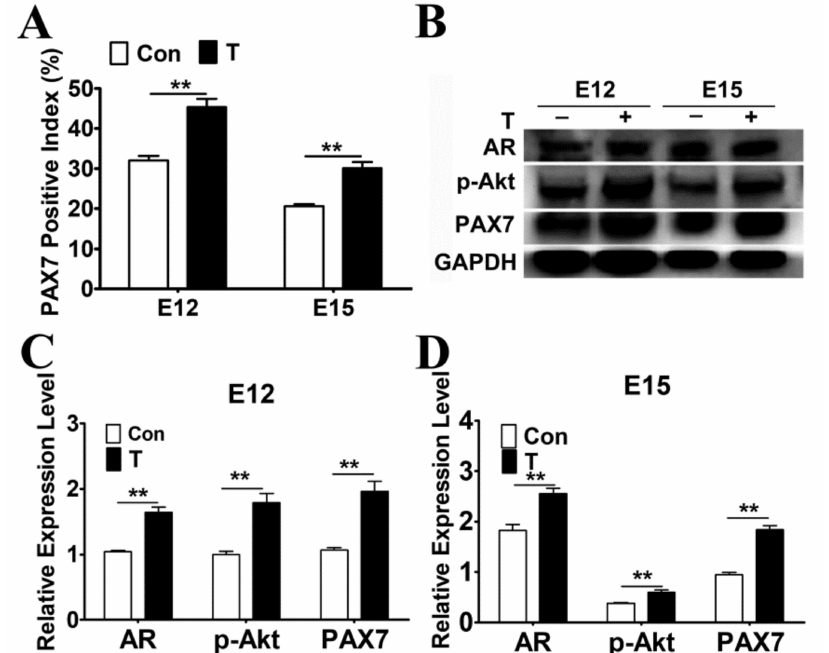
Figure 4. E ff ect of T treatment on the expression of PAX7 in skeletal muscle. ( A ) The positive percentage of PAX7 positive myoblasts in skeletal muscles. ( B–D ) Protein expression of AR, p-Akt and PAX7 after T treatment was measured by western blotting. Asterisk (*) represents statistically di ff erent ( p < 0.05), ** indicates that the di ff erence is extremely significant ( p <